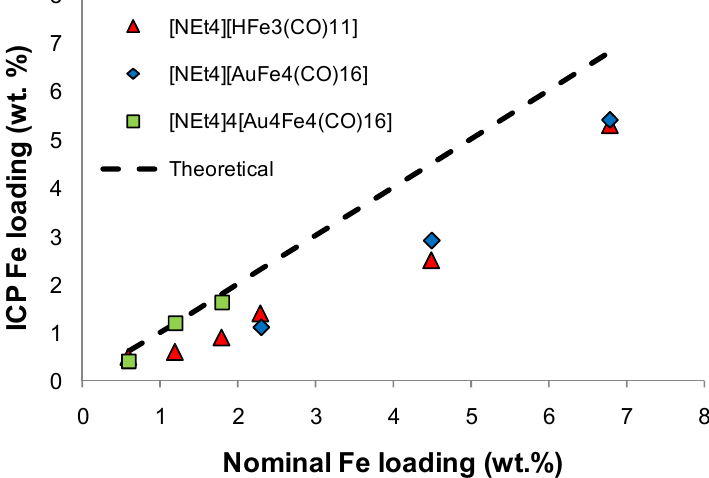
Figure 5. ICP Fe loading vs . nominal Fe content for titania catalysts prepared using, cluster